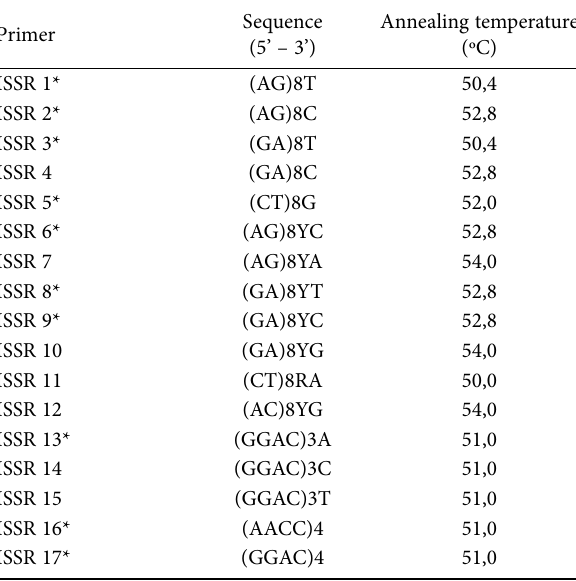
Table 2. ISSR primers tested in this study with sequence and annealing temperature. Selected primers are marked with (*).